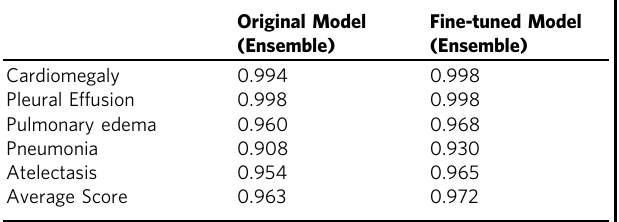
Table 1 Added value of fi ne-tuning with auto-labeled datasets for model generalizability and performance